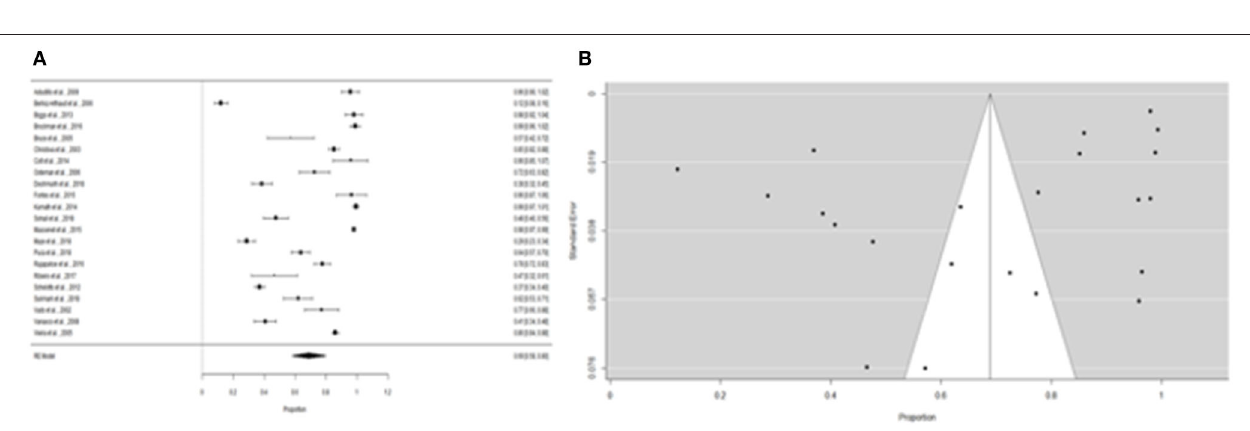
FIGURE 6 | (A) Forest plot of the proportion of “expositional risk” for leptospirosis patients. (B) Funnel plot of the proportion of “expositional risk” for leptospirosis